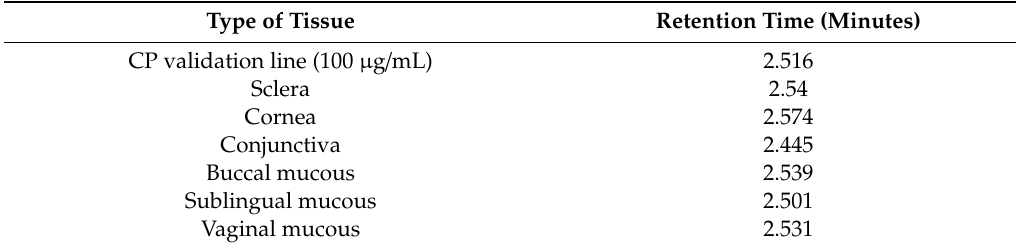
Table 1. Retention times (minutes) of CP-NPs in each studied